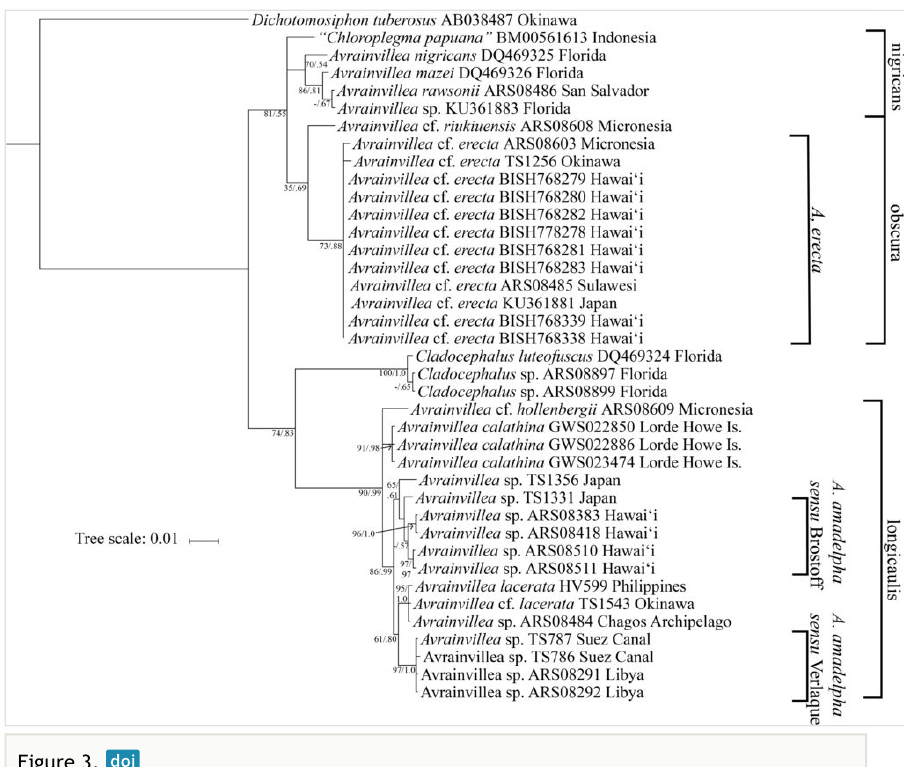
Bayesian inferred phylogeny from the rbc L and tuf A concatenated alignment. The